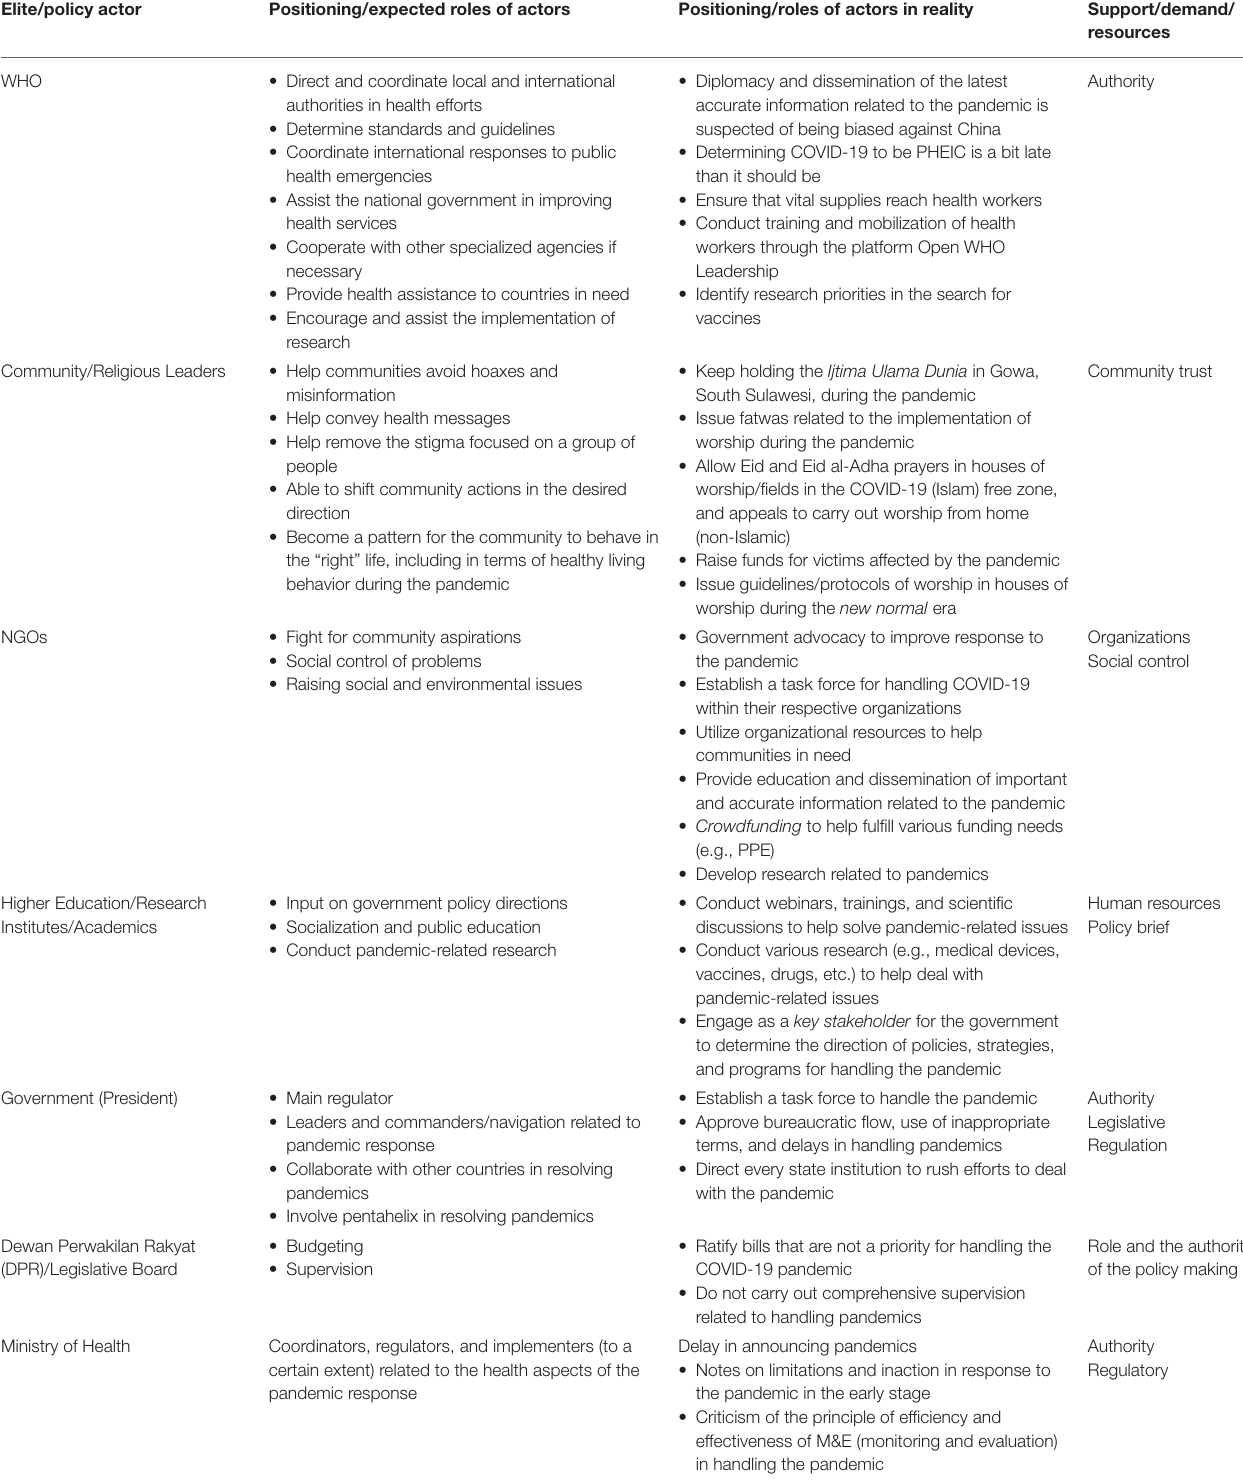
TABLE 1 | Analysis of Easton’s system component mapping (input-process-output-environment). Elite/policy